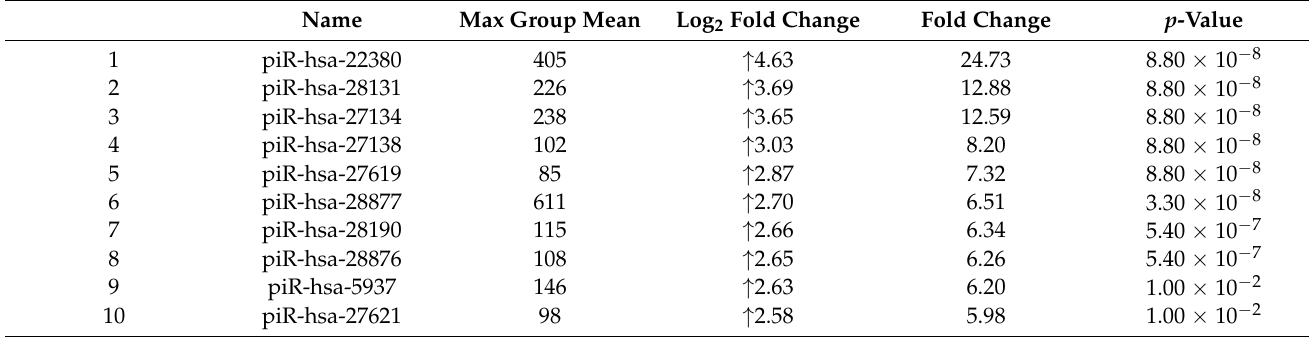
Table 8. Differentially expressed piRNAs (N = 29) between individuals with severe symptoms vs. mild symptoms (Absolute fold change > 2; p <